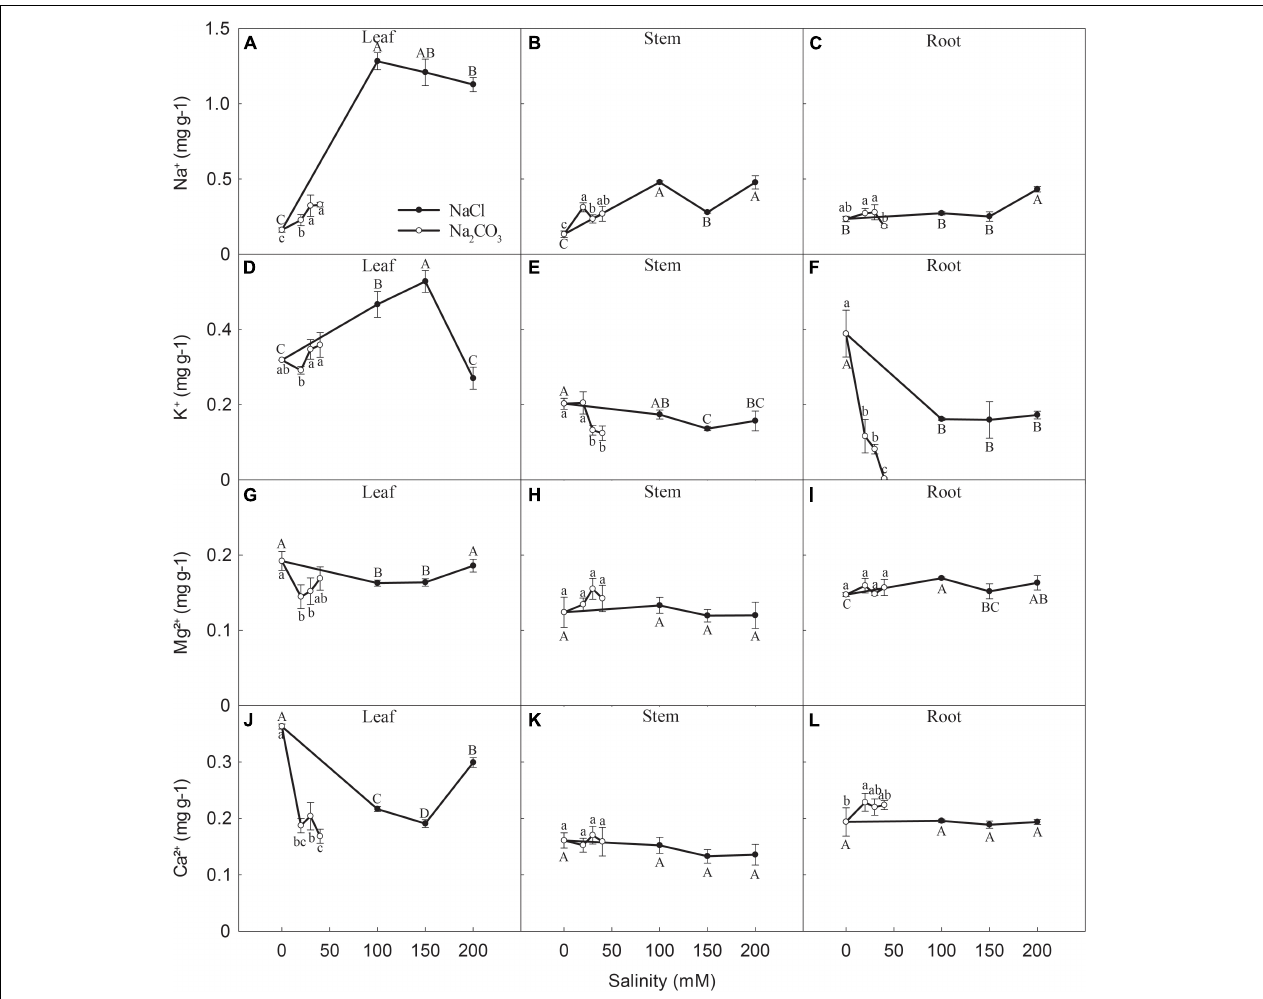
FIGURE 5 | Changes in the concentrations of (A–C) Na + , (D–F) K + , (G–I) Mg 2 + , and (J–L) Ca 2 + in the leaves, stems, and roots of canola seedlings after 7 days of NaCl and Na 2 CO 3 stress. Different uppercase and lowercase letters indicate significant differences among NaCl and Na 2 CO 3 concentrations, respectively, according to a least significant difference (LSD) test ( P < 0.05).